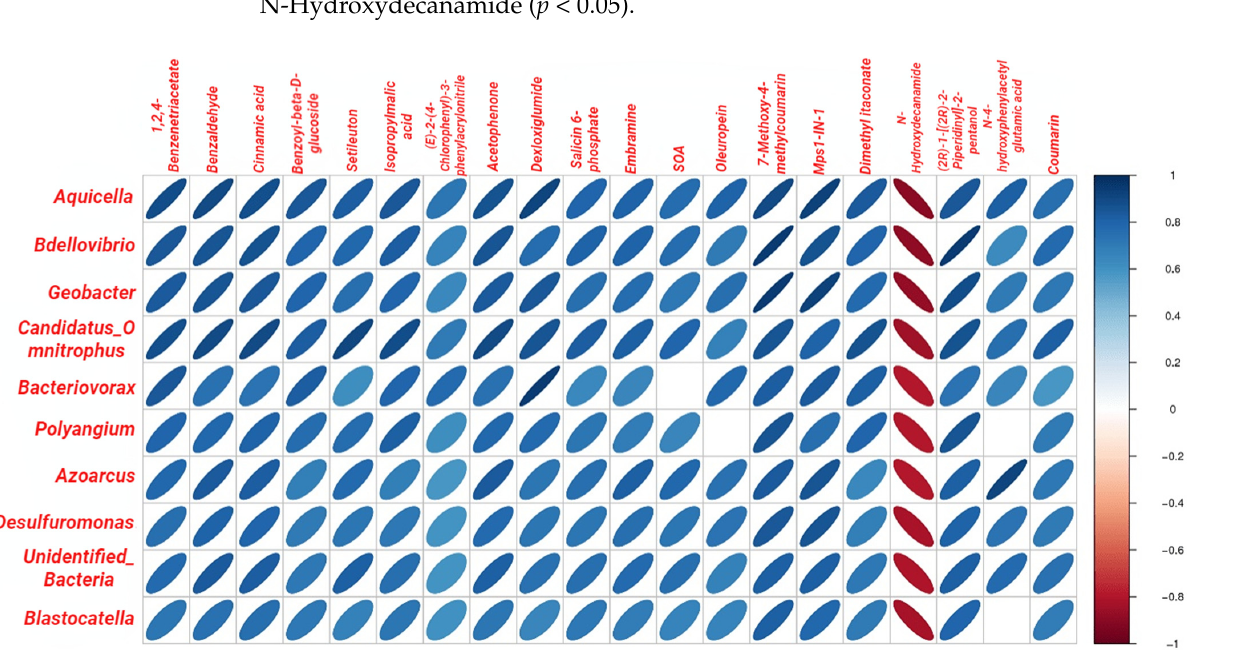
Figure 5. Correlation analysis between bacterial genera in the rhizosphere soil and root metabolites. The thinner the ellipses, the more significant the correlation. The blue-to-red color transition indicates a spectrum ranging from a positive correlation to a negative correlation. Only the metabolites and root metabolites with significant differences between the CK and T200 groups are depicted.